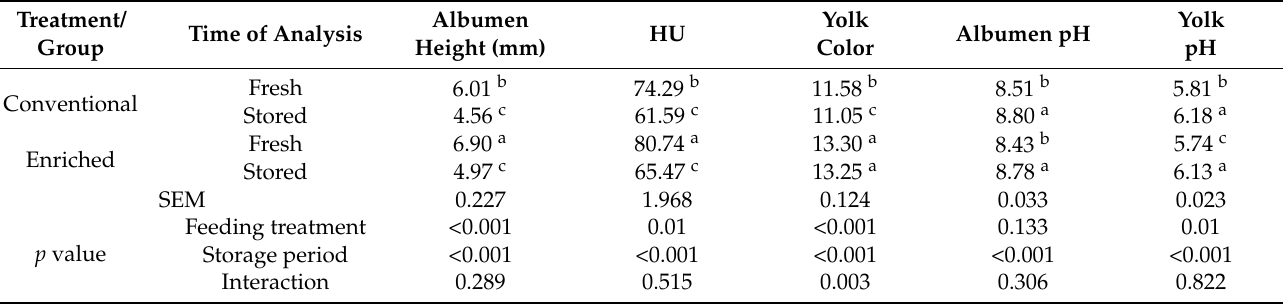
Table 5. Influence of feeding treatments on internal egg quality indicators.